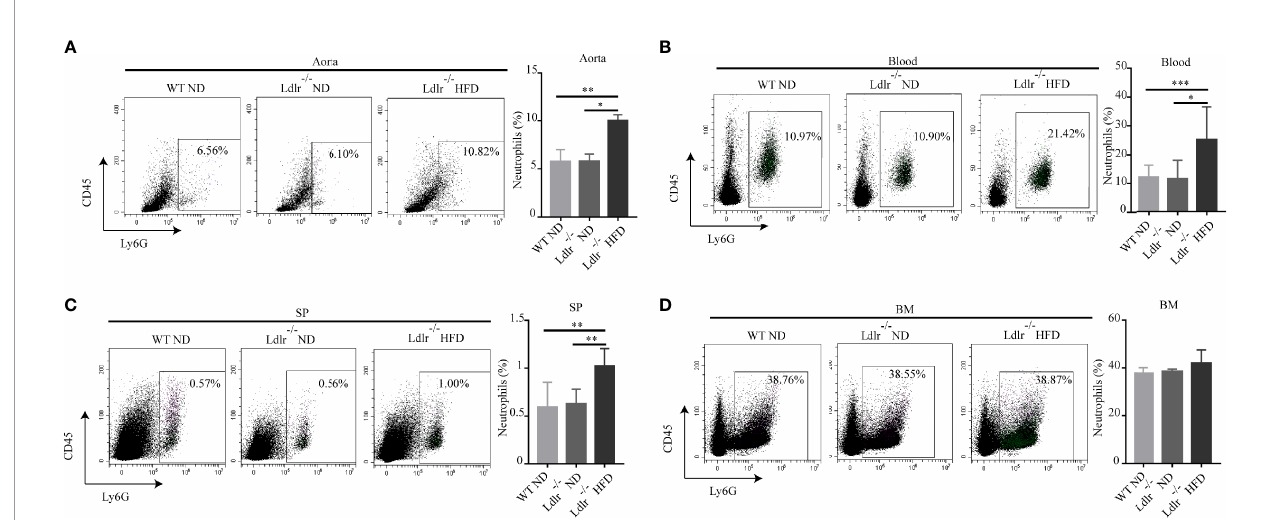
FIGURE 2 | Percentage of neutrophils was higher in LDLr -/- HFD mice than control groups. Distribution of neutrophils in (A) aorta, (B) blood, (C) spleen (SP), (D) bone marrow (BM) of atherosclerotic mice and control groups were detected by fl ow cytometry. n=8. *p < 0.05, **p < 0.01, ***p <